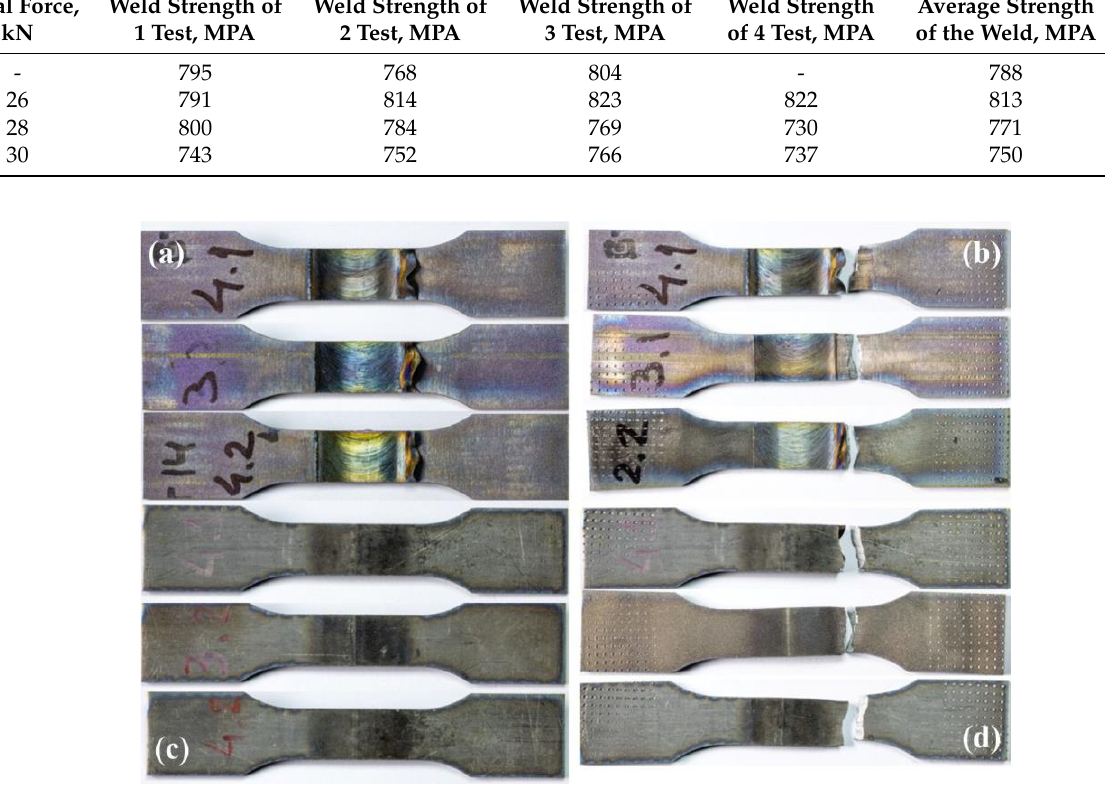
Figure 5. FSW joint tensile specimens of Ti-4Al-3Mo-1V titanium alloy: top view before ( a ) and after testing ( b ), and bottom view before ( c ) and after testing ( d ). testing ( b ), and bottom view before ( c ) and after testing ( d